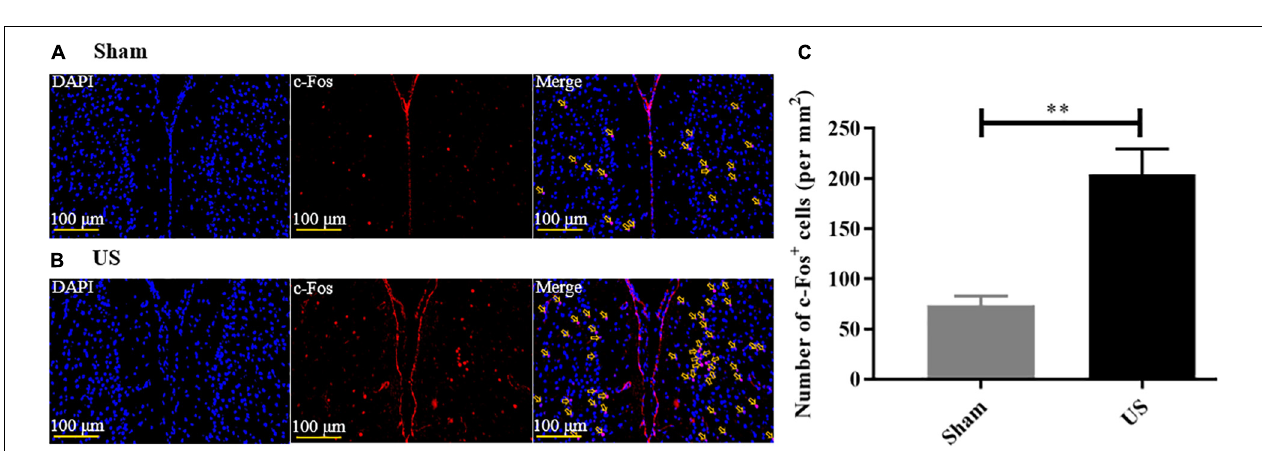
FIGURE 2 | The determination of LPS experimental dose. (A) Motion trail of mice injected with saline and different dose of LPS. (B) Compared with mice injected saline, the number of entries in the central zone of LPS-injected mice was decreased, indicating depressive-like behaviors ( n = 9 in each group). The depressive-like behaviors of mice injected with 1 mg/kg LPS was more obvious. LPS, lipopolysaccharide. ** p < 0.01; **** p < 0.0001.